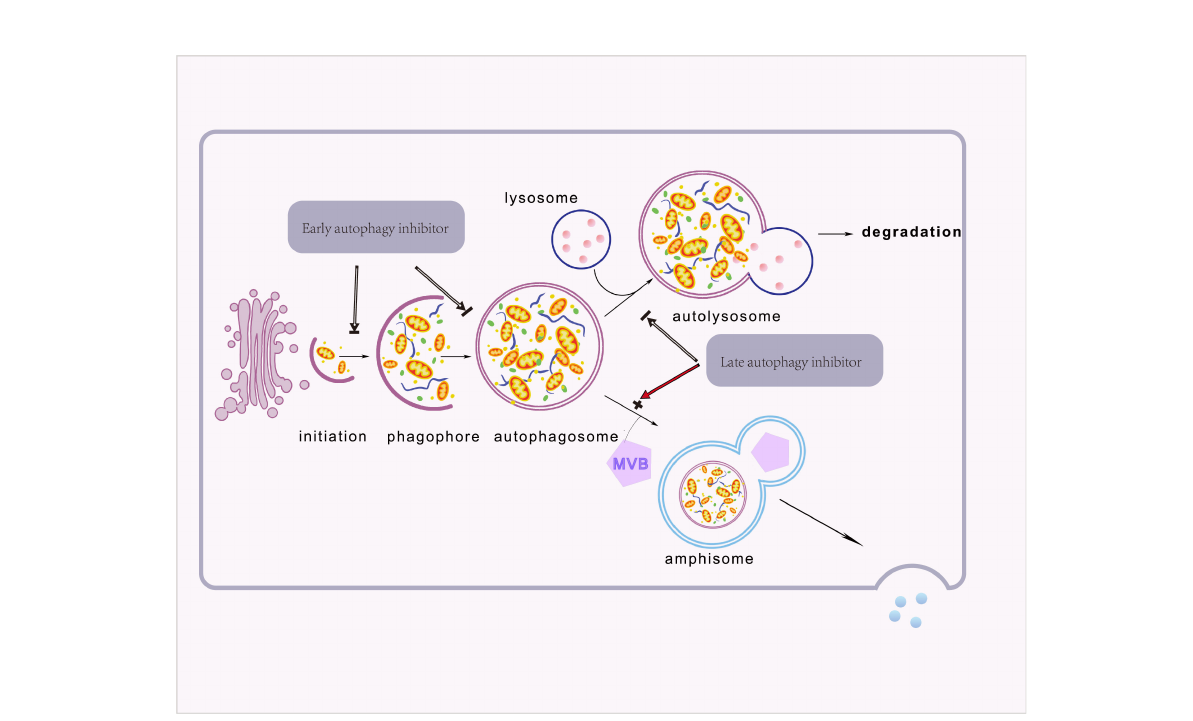
FIGURE 2 The different types of autophagy. Proteins, organelles, and other cellular components are sequestered in a newly formed isolation membrane. This isolation membrane then swells and seals to form a double membrane-bound vesicle, the autophagosome. Degradation of the autophagosome occurs when the autophagosome fuses with the lysosome. In secretory autophagy, Autophagosomes fuse with multivesicular bodies to produce double-membrane bodies that can fuse with the plasma membrane and secrete cargo into the extracellular space. Furthermore, late and early autophagy inhibitors have different effects on